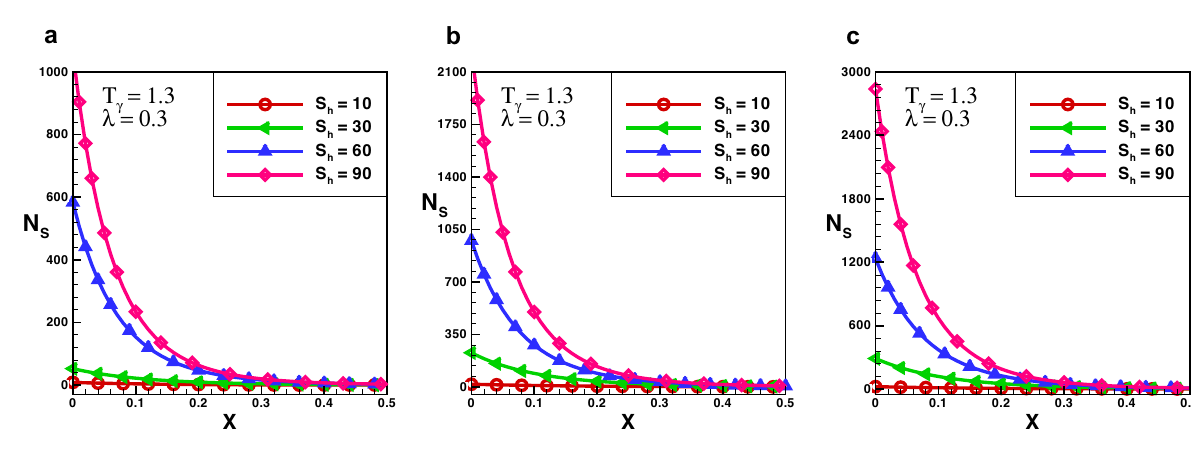
Figure 3. Entropy generation number in rectangular porous fin for (cid:31) = 0.3